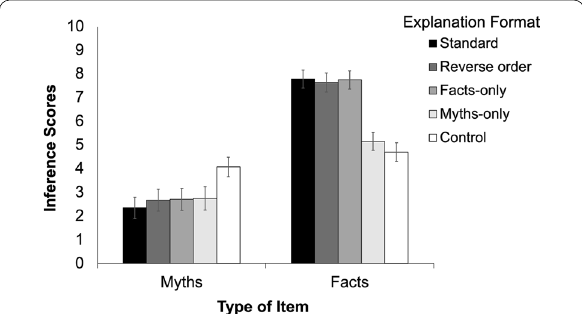
Fig. 2 Belief ratings across conditions in Experiment 3. Error bars denote 95% confidence intervals